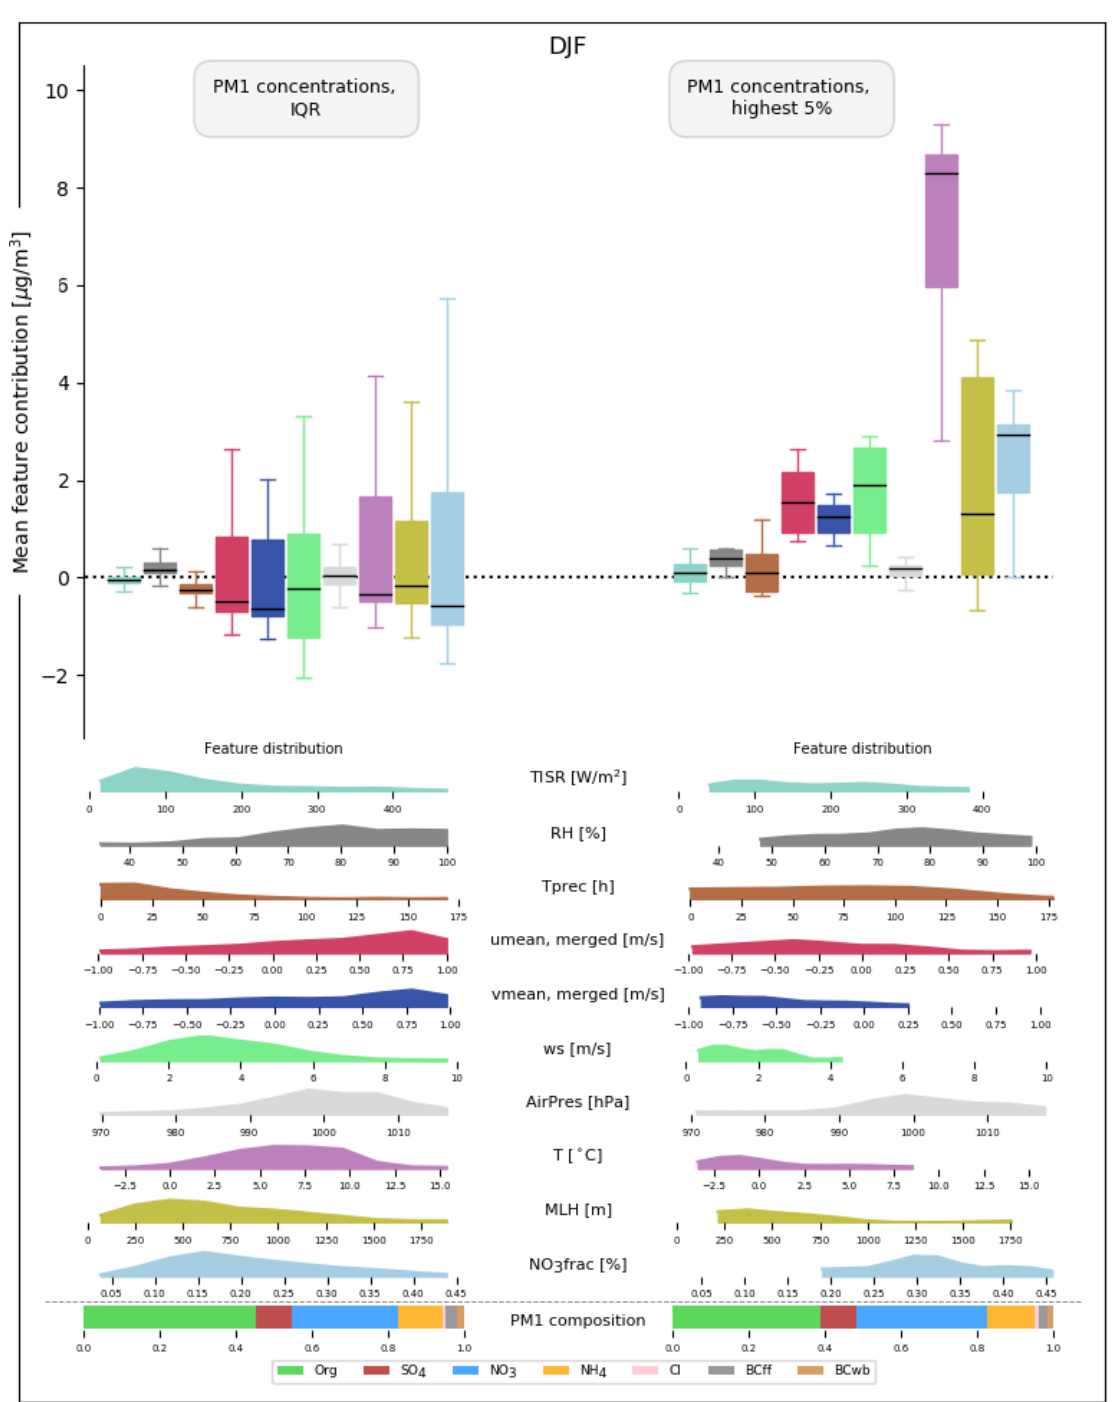
Figure 9. Mean feature contributions (i.e. SHAP values) for situations with low total PM 1 concentrations (left) and situations with high pollution (right), respectively, during winter (December, January, February). Respective ranges of SHAP values by species are shown as box plots, with median (bold line), 25–75th percentile range (boxes), and 10–90th percentile range (whiskers). Both training and test data are included. Absolute feature value distributions (given as normalized frequencies) as well as the chemical composition of the total PM 1 concentration are shown in the subpanels. Colours of the box plots correspond to colours in the feature distribution subpanels. SHAP values of the input features u_norm_3d and u_norm as well as v_norm_3d and v_norm were merged to “u_norm, merged” and “v_norm, merged” to achieve better